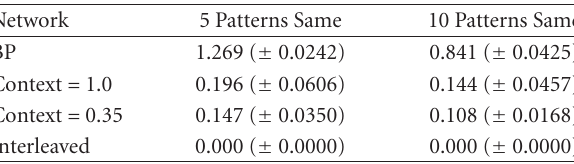
Table 2: Mean and standard error of SSE ratios for Base Task, when di ff erent interfering tasks were used. The first row gives the ratio for a BP network, the second row for a Leabra network with contextual cues of strength 1.0, the third row for a Leabra network with contextual cues of strength 0.35, and the fourth row for a Leabra network trained in an interleaved manner for the two tasks. A smaller ratio signifies more